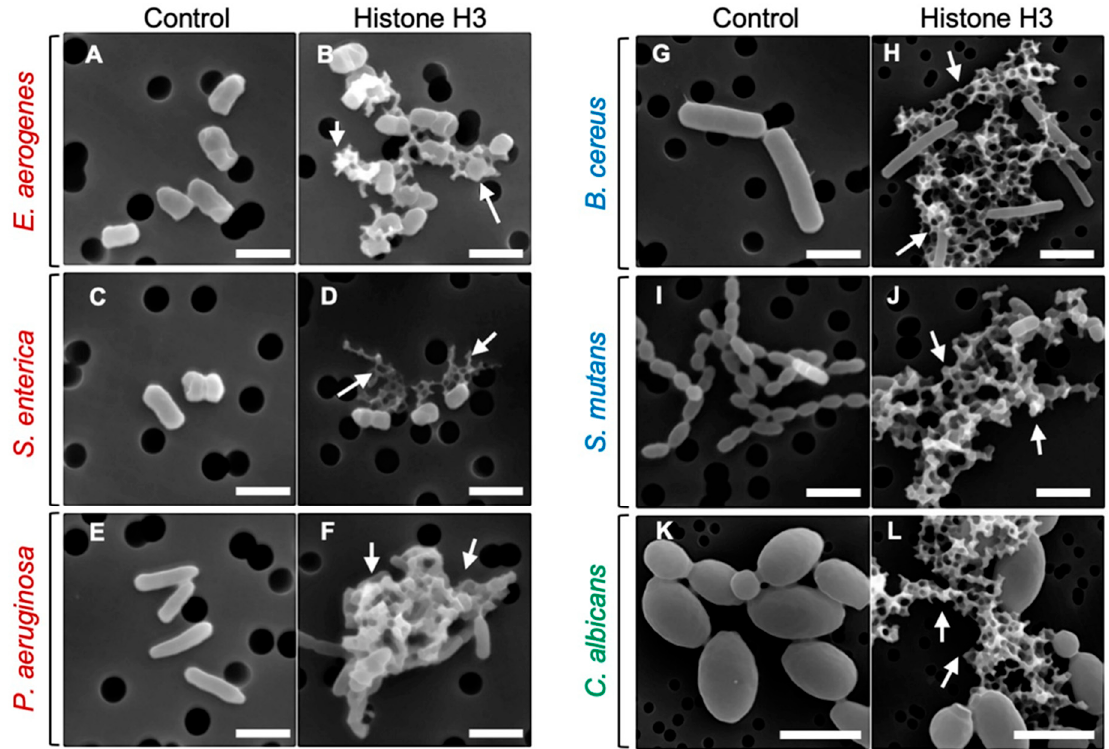
Figure 2. Scanning electron microscopy (SEM) images of bacterial and fungal cells following the treatment with histone H3. Aliquots of E. aerogenes ( A , B ), S. enterica ( C , D ), P. aeruginosa ( E , F ), B. cereus ( G , H ), S. mutans ( I , J ), or C. albicans ( K , L ) cultures at the mid-logarithmic growth phase were incubated with myoglobin (negative control) or histone H3 at 64 μ g/mL for 1 h ( A , B , I , J ) or 4 h ( C – H , K , L ) at 25 °C, and were then examined using SEM. Abnormally shaped cells indicating cell surface destruction (arrows) are visible in each panel when compared with myoglobin-treated cells. Bars, 1 μ m. Note that the black circles behind the cells are filter pores.